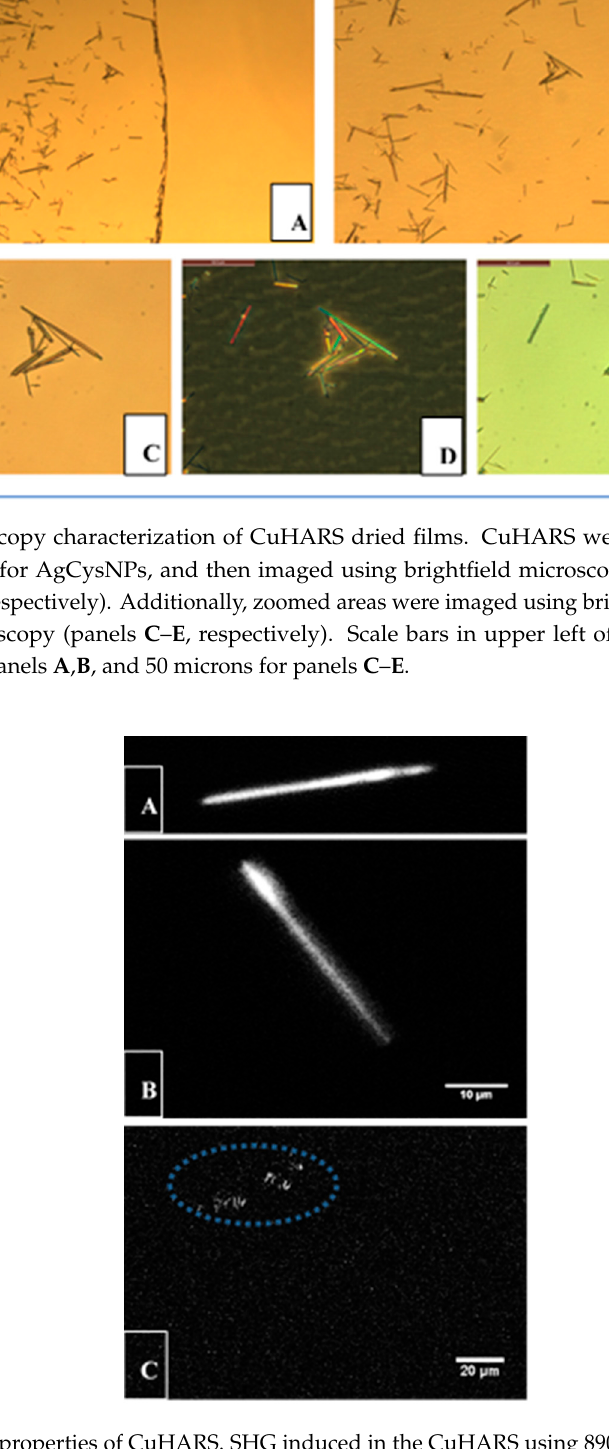
Figure 7. Optical properties of CuHARS. SHG induced in the CuHARS using 890-nm, scanned, pulsed laser light from a multiphoton laser. ( A , B ): Two individual CuHARS lying on a glass microscope slide with a No. 1.5 glass coverslip are shown. ( C ) Rapid degradation of single CuHARS using higher laser power. Only small, particulate-like material remains after photo destruction of the CuHARS (remaining particulates are inscribed by dotted ellipse). Scale bars are 10 microns for panels A , B , and 20 microns for panel C